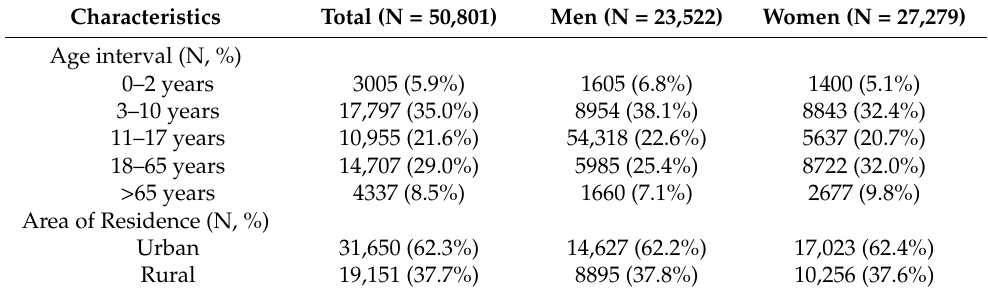
Table 1. Demographic characteristics of patients with